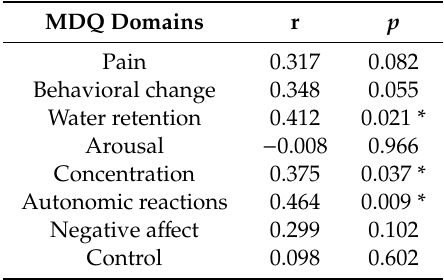
Table 2. Relationship between the initial ML performance gain and